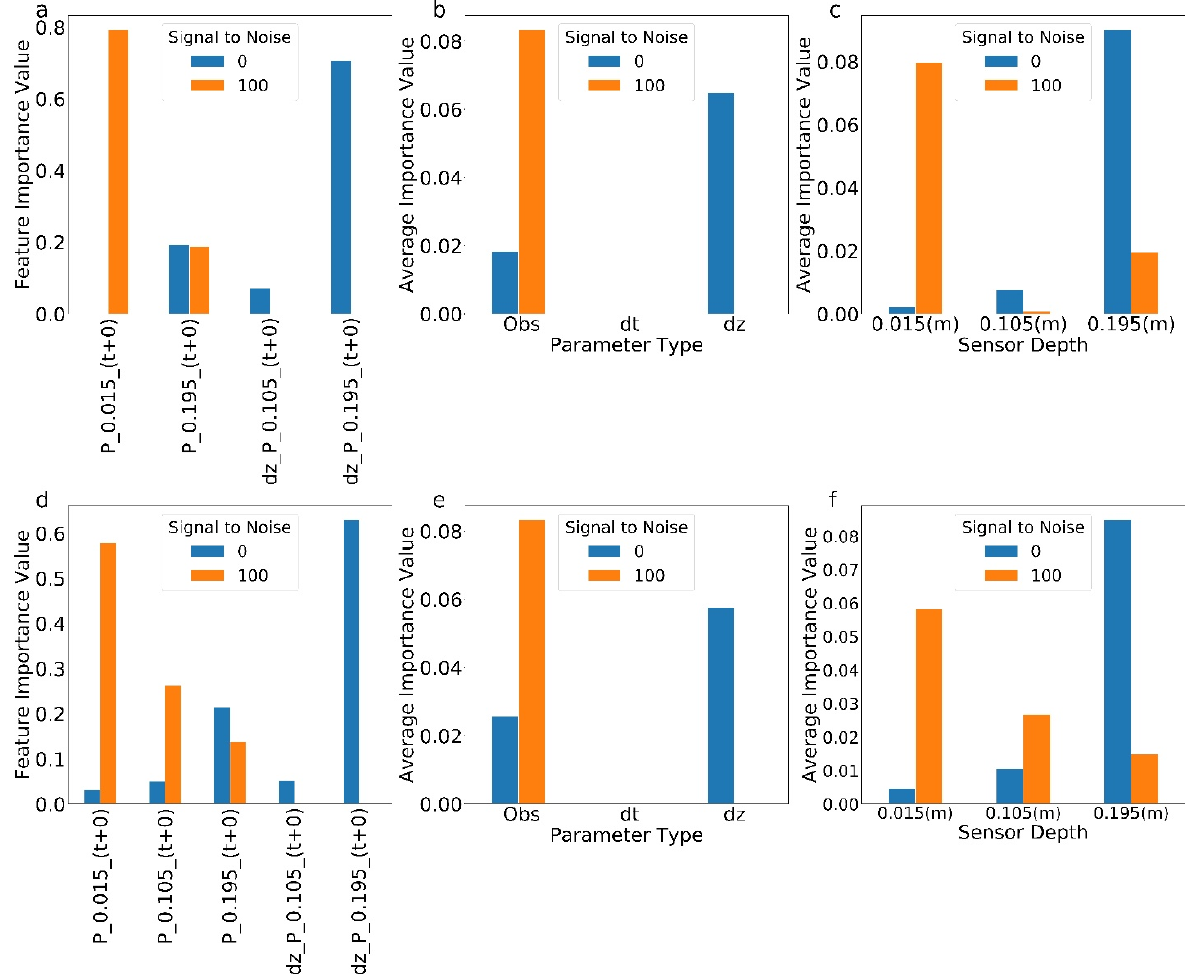
Figure 6. Figures ( a ) through ( c ) show results for RT; ( d ) through ( f ) relate to GB. ( a , d ) Feature importance for pressure and temperature observations (P and T) and spatial (dz) and temporal (dt) gradients for sensors at 0.015, 0.105, and 0.195 m depths with (orange) and without (blue) measurement error. The time delay after the flux estimation is shown in parentheses, and features with less than 0.001 importance value are not shown in the x axis. ( b , e ) Summary of feature importance by type–observed value, temporal gradient (dt), and spatial gradient (dz). ( c , f ) Summary of feature importance by depth.